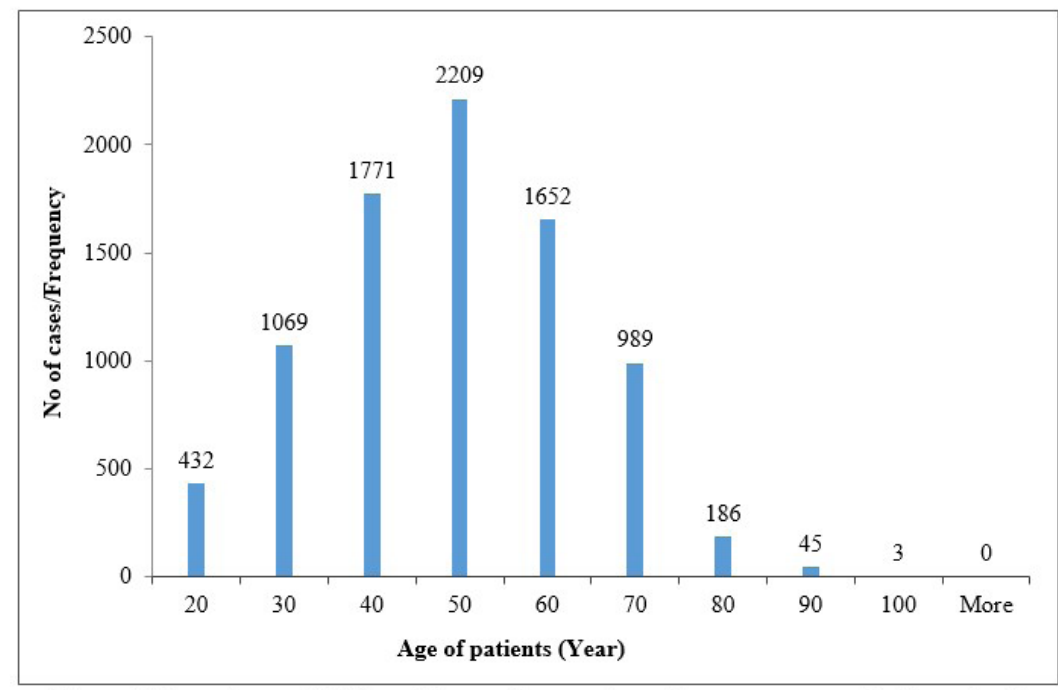
Figure 2 - Prevalence of different types of cancer in various age groups (Both